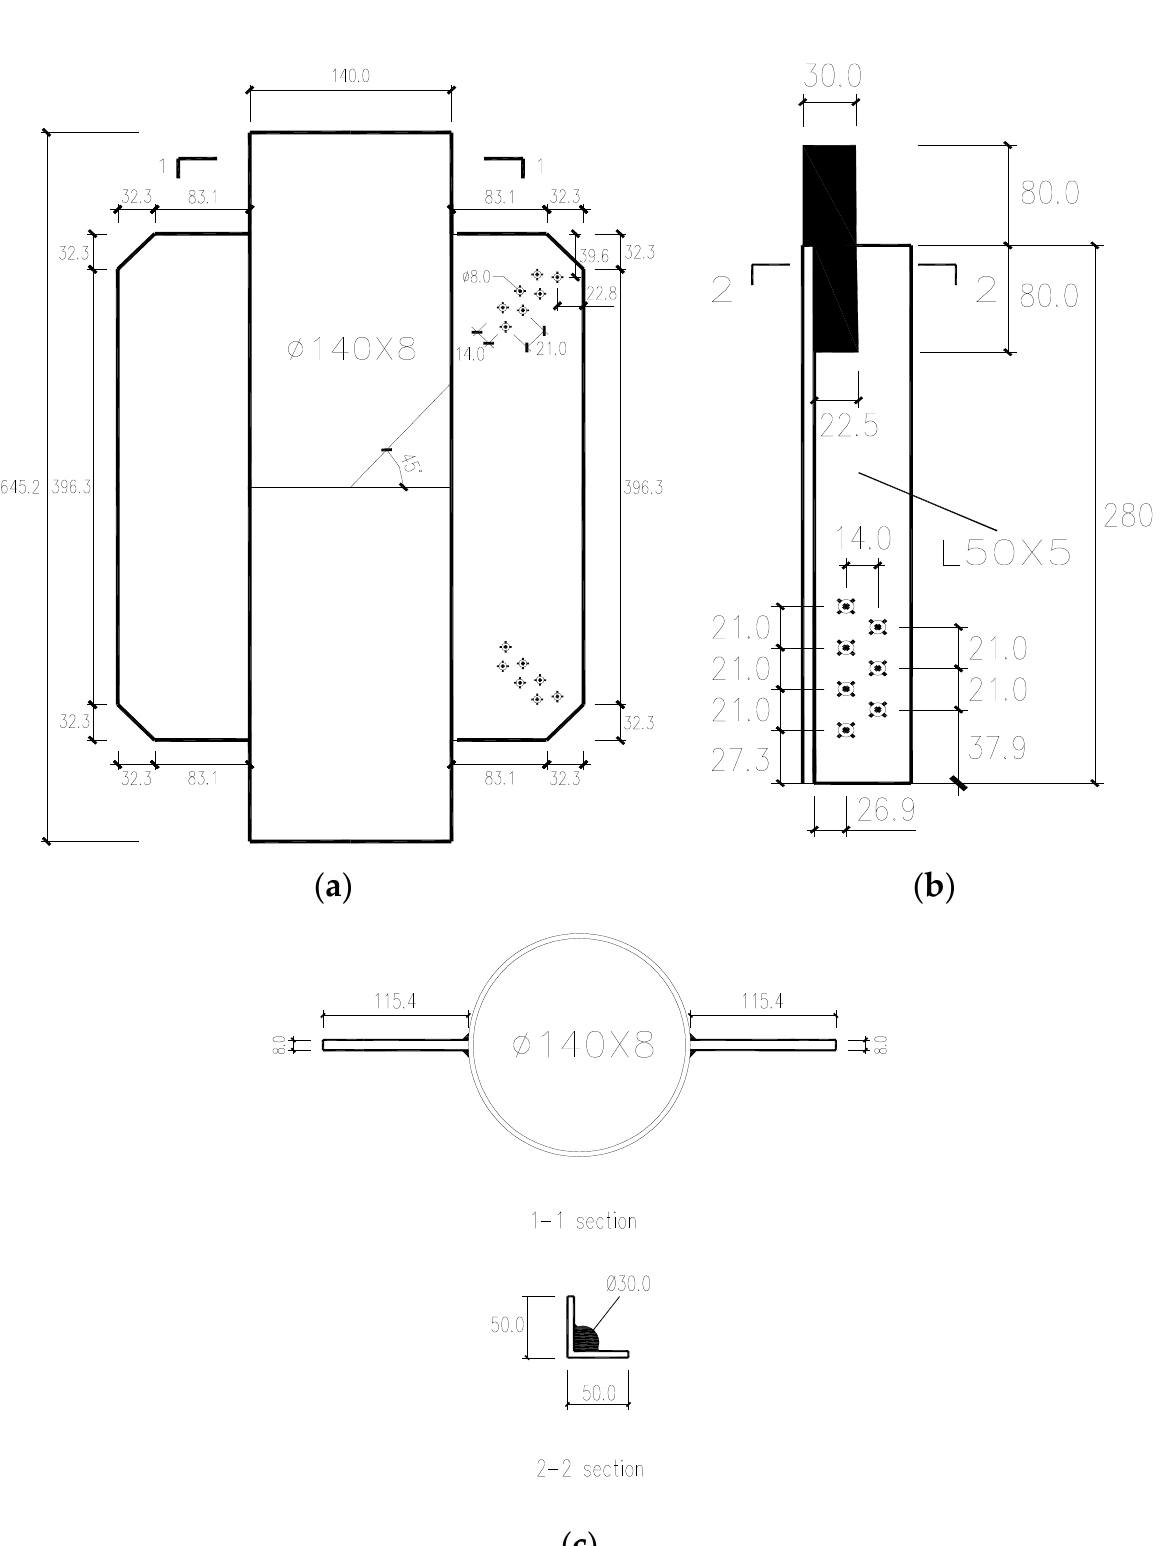
Figure 2. ( a ) Elevation of 1:5 scale model of SLSPJ; ( b ) front view of connecting angle steel of 1:5 scale model of SLSPJ; ( c ) section of 1:5 scale model of SLSPJ.